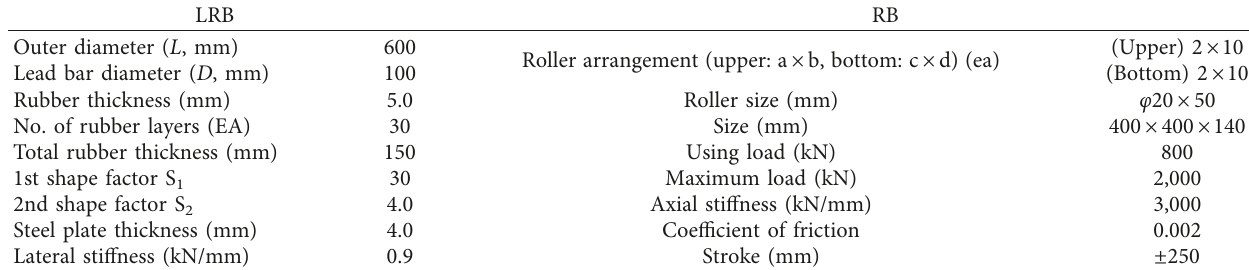
Table 3: LRB and RB device details.